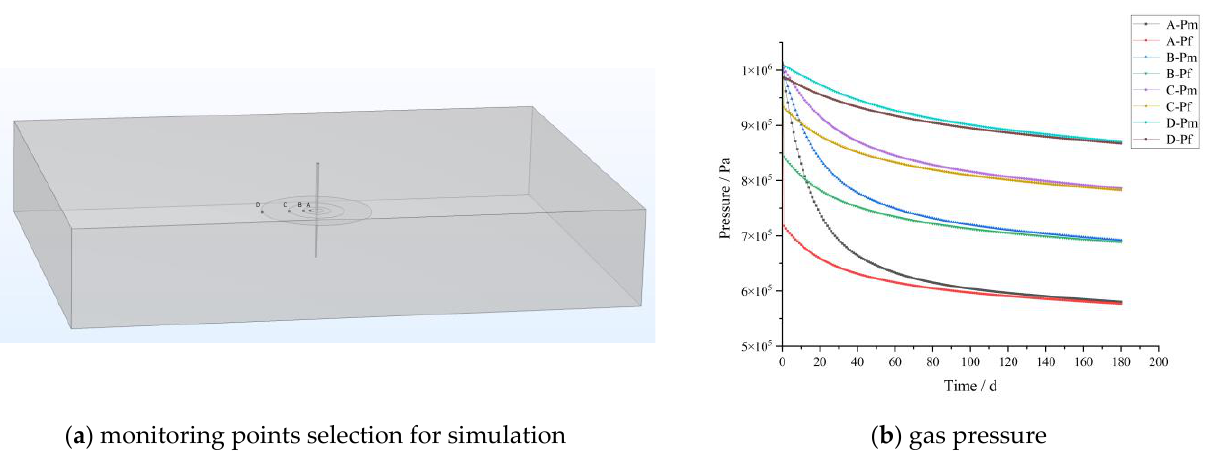
Figure 3. Coal matrix and fracture gas pressure under different extraction time.